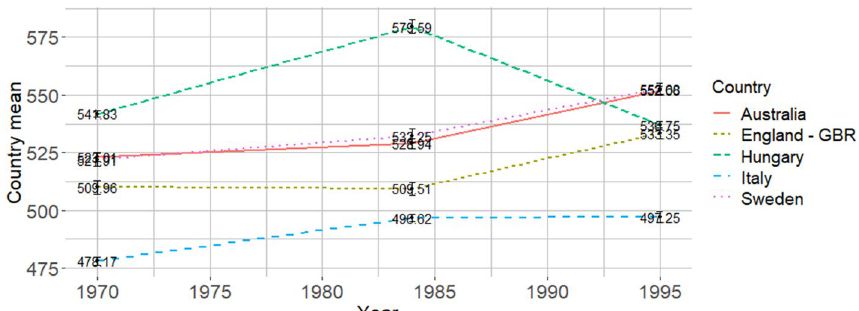
Fig. 3 Trends of grade 8 science